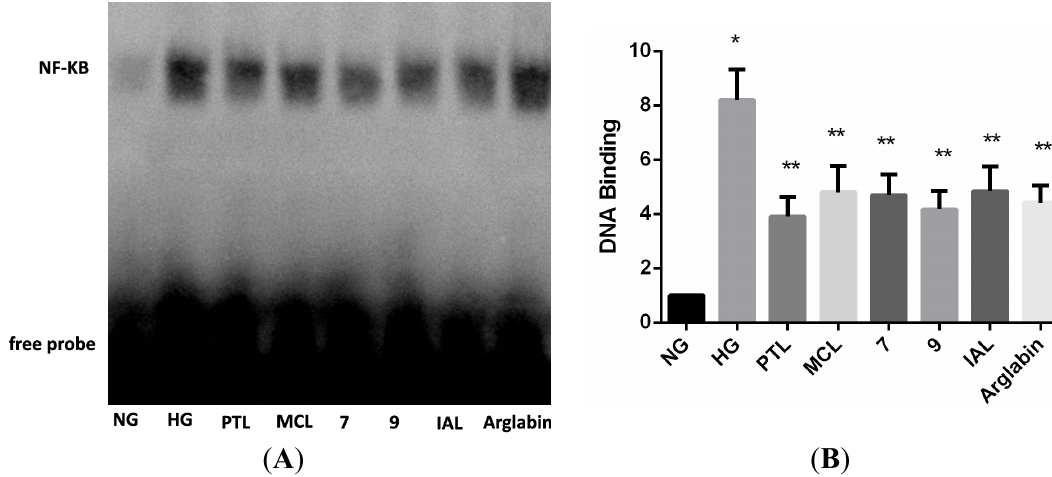
Figure 6. Sesquiterpene lactones inhibits high glucose-mediated NF- κ B DNA binding activity. Mesangial cells treated with 10 μ M of PTL, MCL, IAL, 7 , 9 and Arglabin for 1 h prior to high glucose induction were analyzed for NF- κ B DNA binding activity by electrophoretic mobility shift assays (EMSA). NG: normal glucose; HG: high glucose.